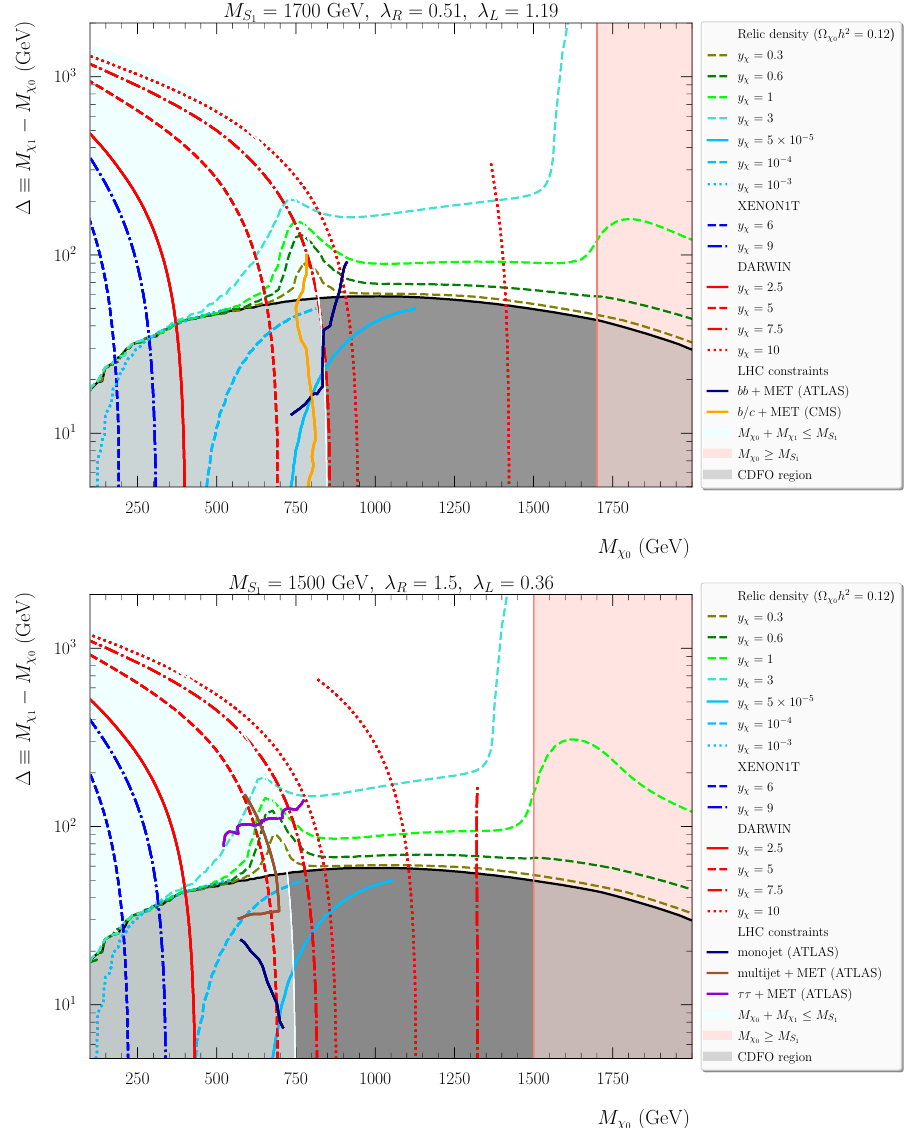
Figure 17 . Summary of all existing constraints on BS1c (upper) and BS2b (lower) scenarios, presented in the ( M χ , ∆) plane. All points are compatible with the DM relic density as measured 1 by Planck, the y value being inferred from that constraint. We indicate several y isolines, for y χ = χ χ 0 . 3 (olive), 0 . 6 (green), 1 (lime) and 3 (turquoise). We additionally display the mass combinations excluded by DM direct detection measurements at Xenon1T for a given y value through dashed χ (for y = 6 ) and dash-dotted (for y = 9 ) blue lines, and the corresponding expectation of the χ χ DARWIN experiment through red lines for y = 2 . 5 (solid), 5 (dashed), 7.5 (dash-dotted) and 10 χ (dotted). LHC constraints exclude the lower M χ regime through b ¯ b plus missing energy (blue), 0 b -jet and c -jet plus missing energy (yellow), mono-jet (blue), multi-jet plus missing energy (brown) and di-tau plus missing energy (purple) searches. The light rose area indicates the region where dark leptoquark decays are